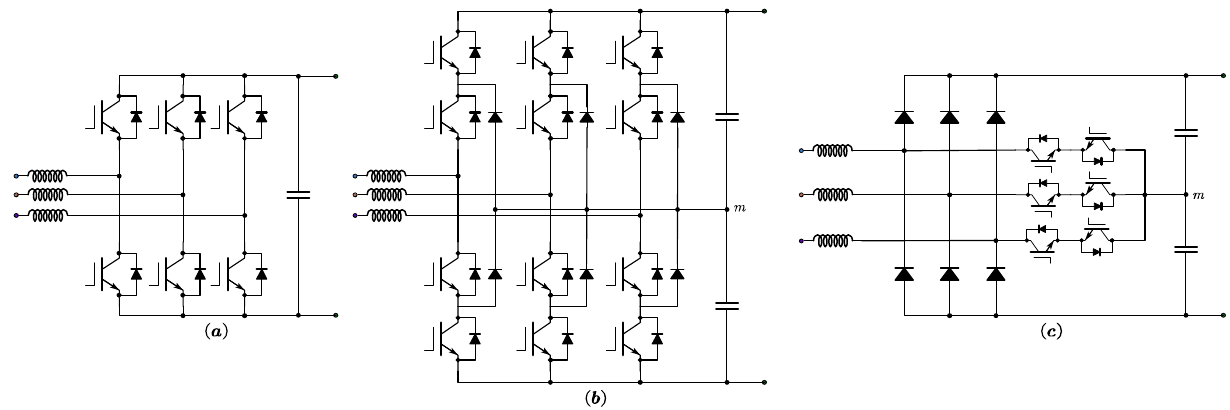
Figure 5. DC-AC converter topologies for electric vehicle ultra-fast charging application: ( a ) three- phase two-level rectifier; ( b ) NPC converter; ( c ) Vienna rectifier.